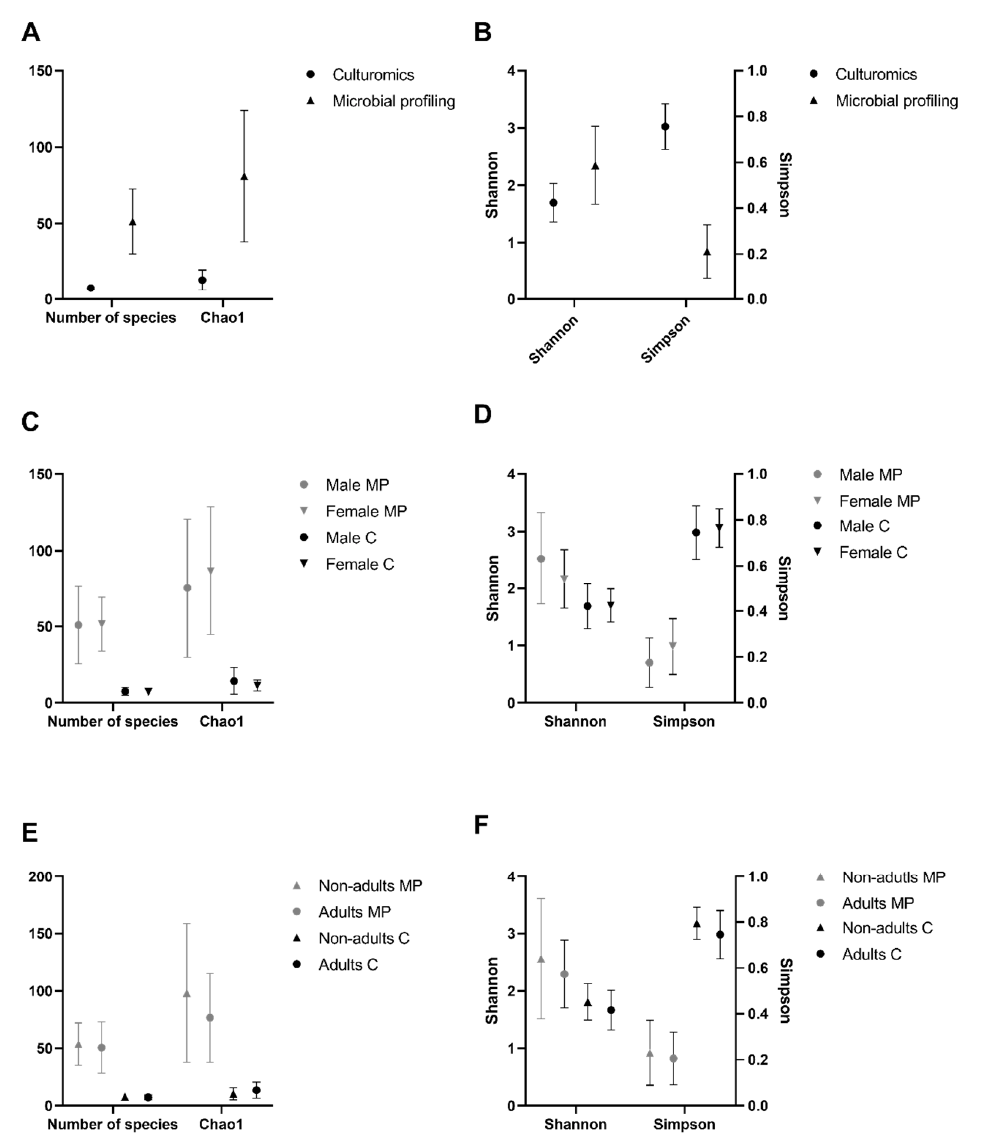
Figure 4. Comparison of the α -diversity indices across sex and age classes of Egyptian mongoose microbiota determined through culturomics and microbial profiling [10] approaches. ( A ) Richness indices (number of species and Chao1) and ( B ) diversity indices (Shannon and Simpson) of culturomics and microbial profiling approaches; ( C ) Richness indices (number of species and Chao1) and ( D ) diversity indices (Shannon and Simpson) of female and male individuals; ( E ) Richness indices (number of species and Chao1) and ( F ) diversity indices (Shannon and Simpson) of nonadult and adult individuals .